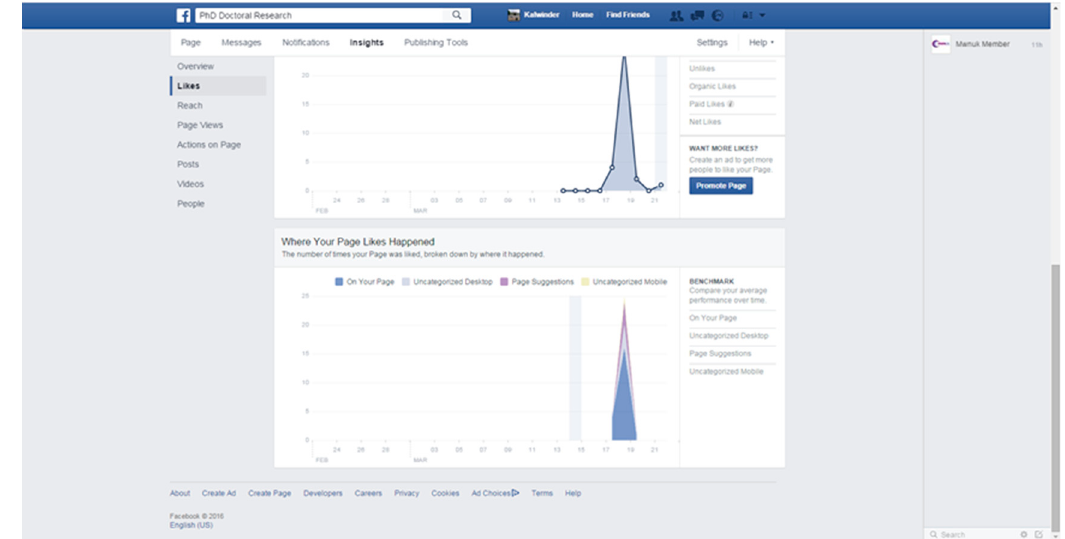
Figure 2. Where the ‘likes’ to the page were generated.